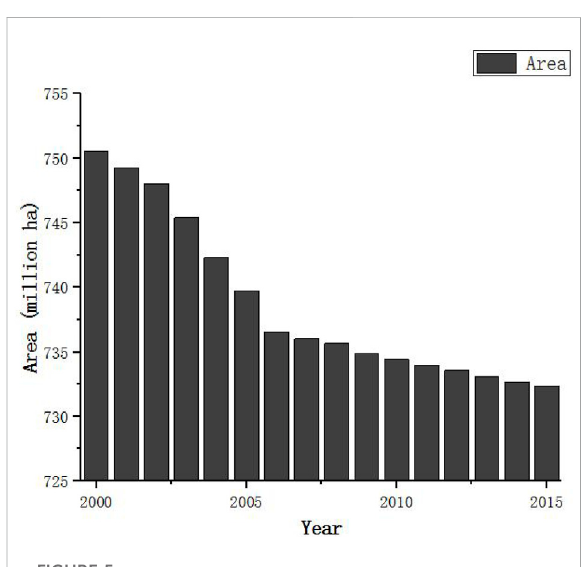
FIGURE 5 Area change of China ’ s ecological space from 2000 to